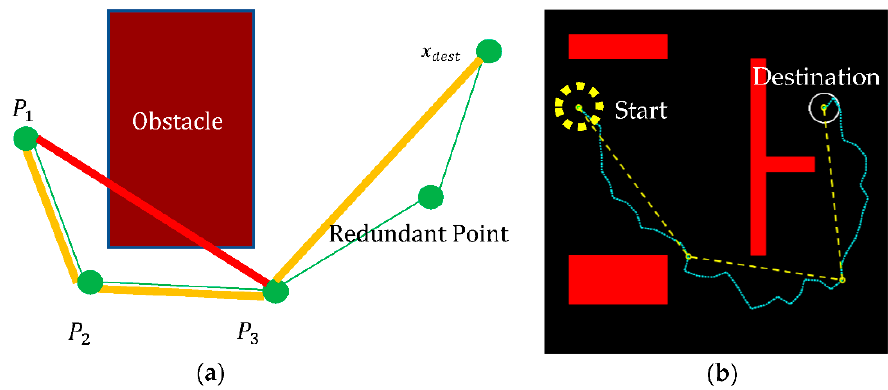
Figure 2. ( a ) Illustration of the pruning process by taking three consecutive path points P 1 , P 2 , and P 3 to check if the new connection P 1 to P 3 is safe. If so, P 2 is redundant; if not, P 2 remains the path point. ( b ) The path after the pruning process (dash line) compared with that of the RRT algorithm (dot line).